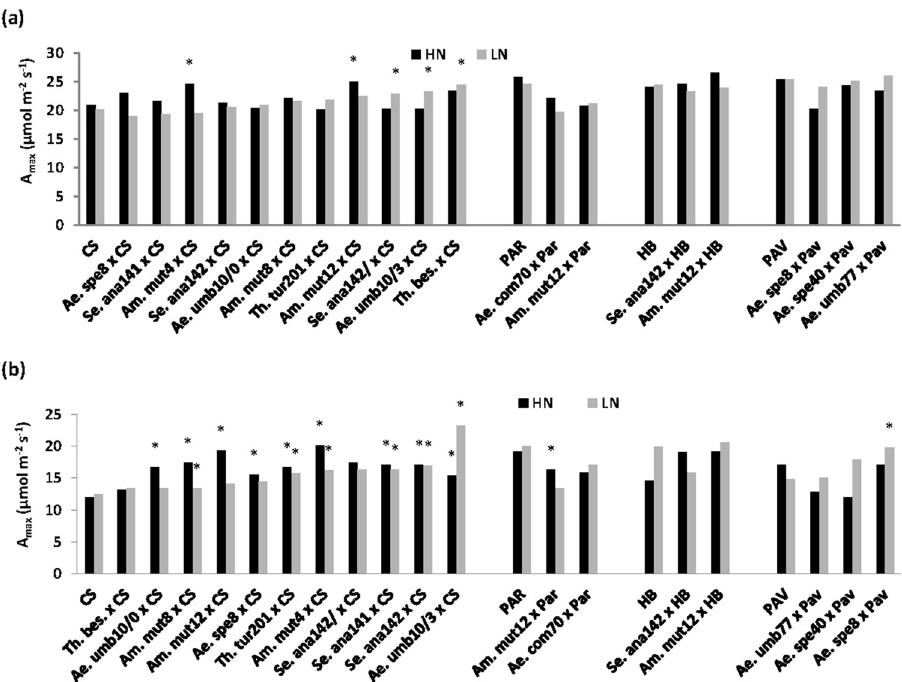
Fig 2. (a) Pre-anthesis flag-leaf photosynthesis rate (Pre-An A max ) and (b) post-anthesis flag-leaf photosynthesis rate (Post-An A max ) for 22 genotypes (18 amphidiploid lines and 4 bread wheat parents) under HN and LN conditions (mean 2015 and 2016) ( � indicates transgressive segregation above respective bread wheat parent at 5% level of